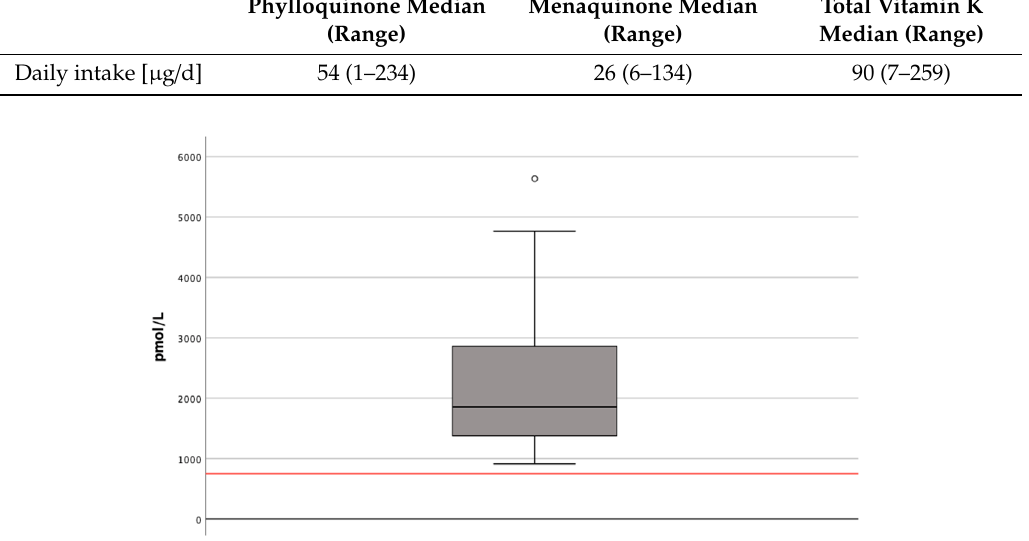
Figure 1. Plasma dp-ucMGP concentrations before dialysis treatment. The reference value (750 pmol/L) is marked with a red horizontal line ( N = 30). The boxplot shows the median, the interquartile range and the ranges. ° represents an outlier